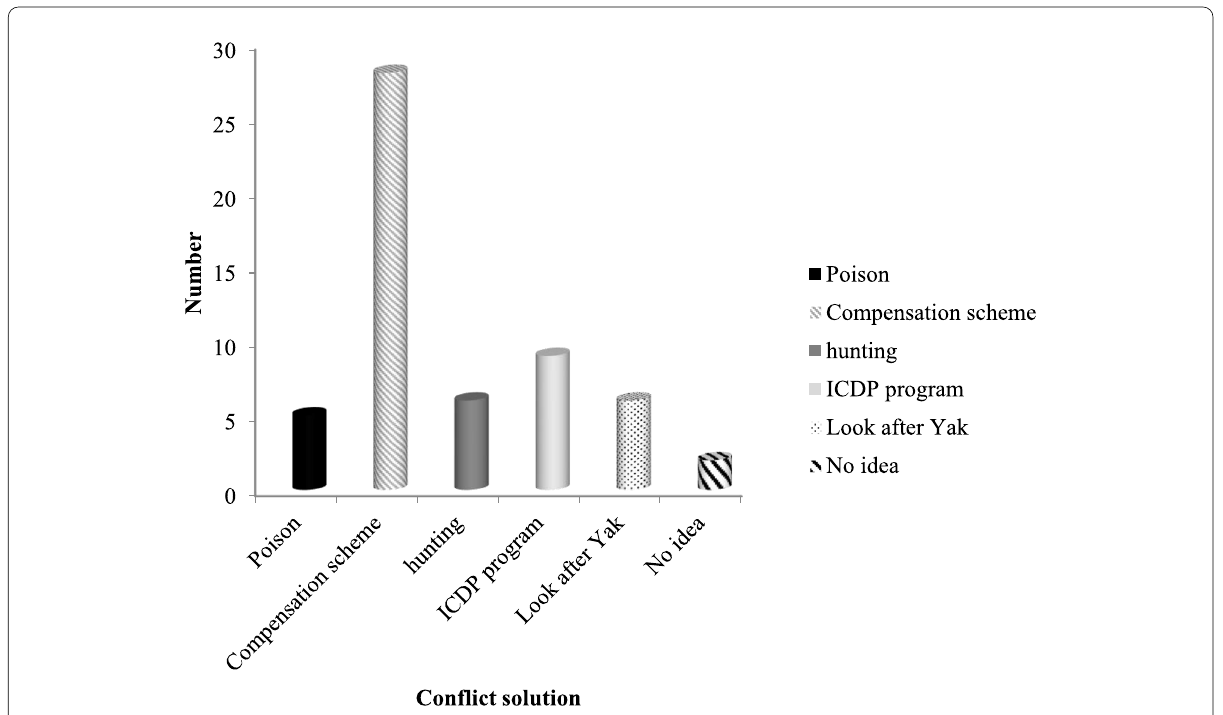
Fig. 6 Perception of conflict solution